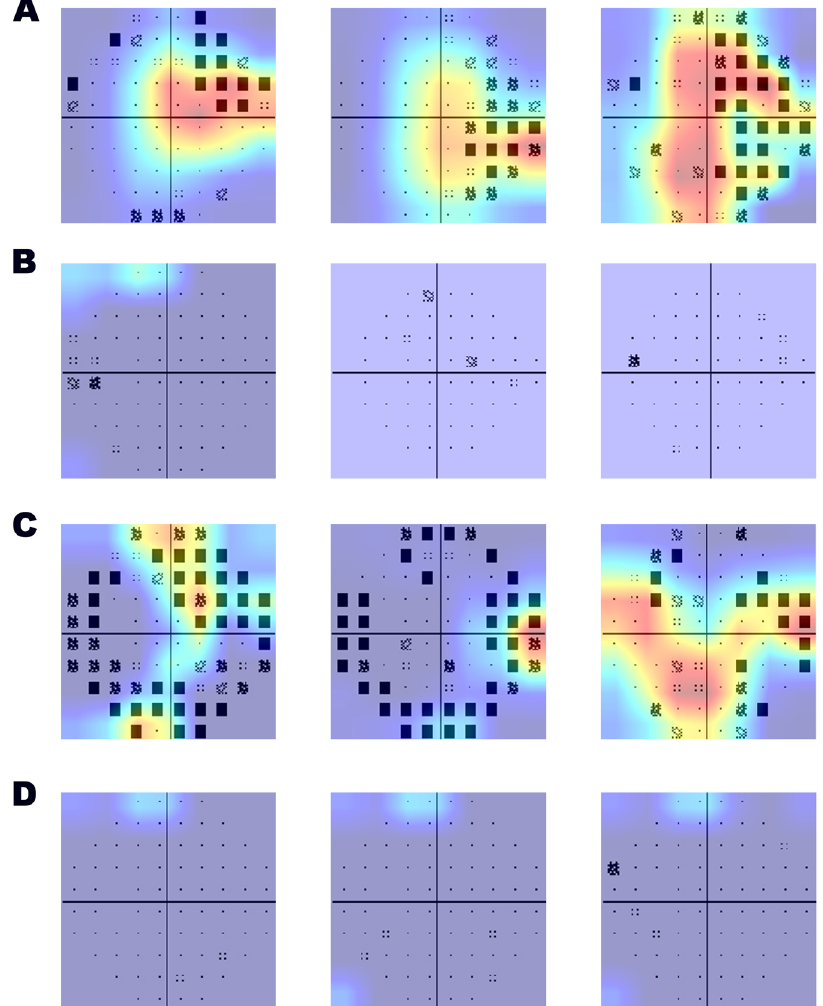
Fig. 2 Representative heatmaps generated by the CNNs. The fi gure shows the heatmaps of the typical samples of eyes with and without glaucoma detected by the PDP-CNN. a and b stand for the heatmaps generated in the true-positive and true-negative cases, while c and d stand for the false-positive and false-negative